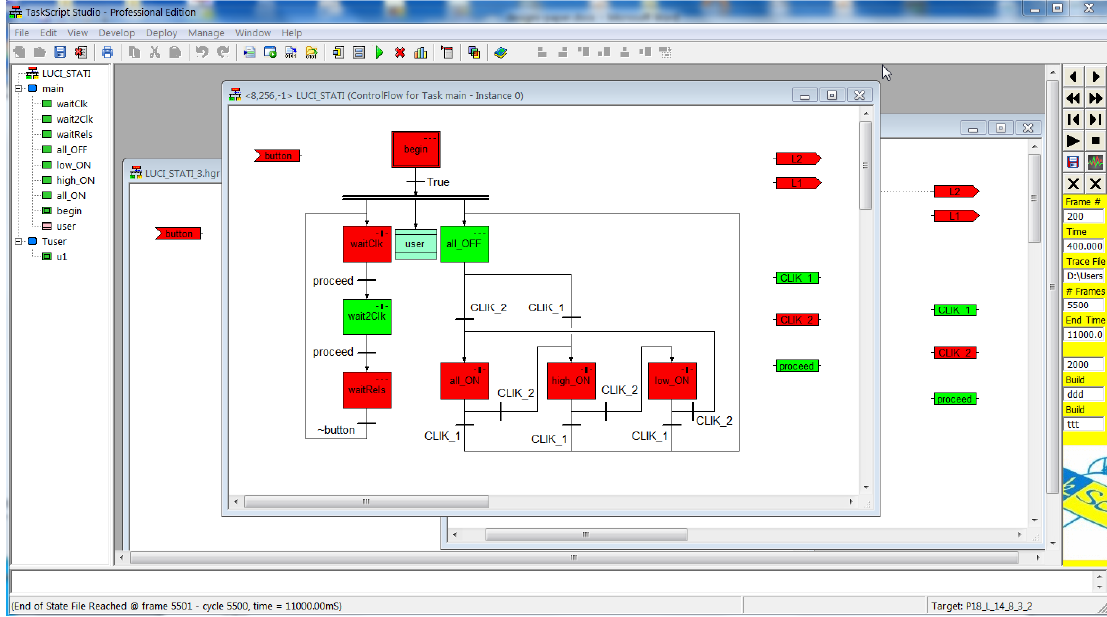
Figure 21. Structural visualization of simulation results.